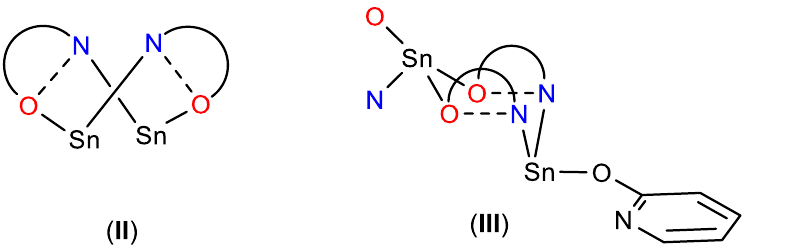
Scheme 6. Schematic drawing showing the coordination of the {hp} ligands in complex